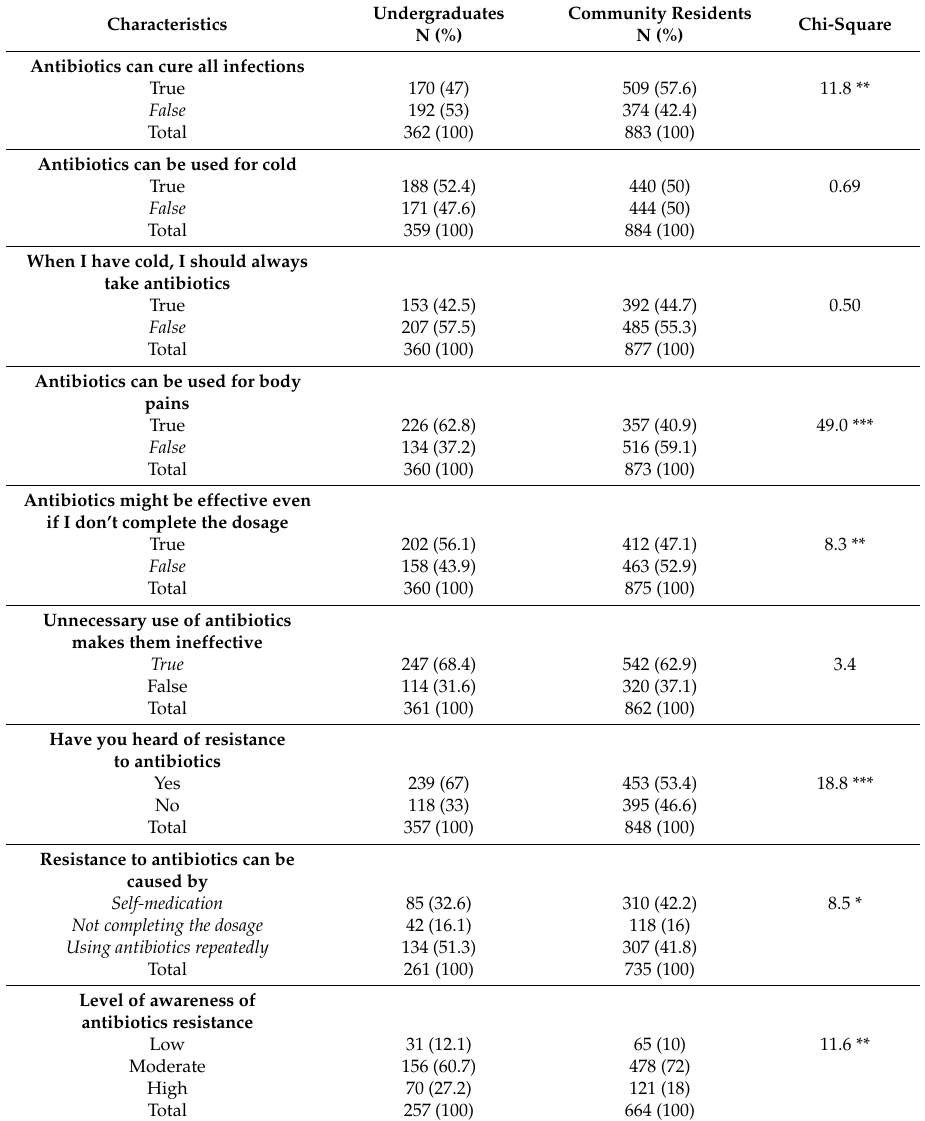
Table 4. Frequency and percentage distribution of knowledge of antibiotics